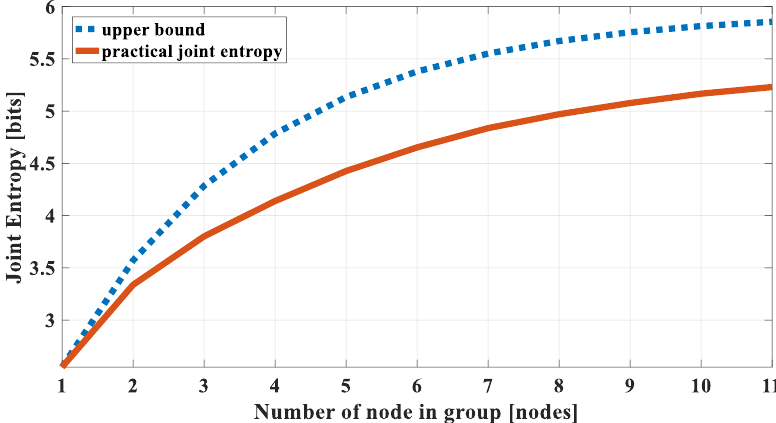
Figure 4. Estimated joint entropy (by the upper bound) and practical joint entropy of dataset 1.